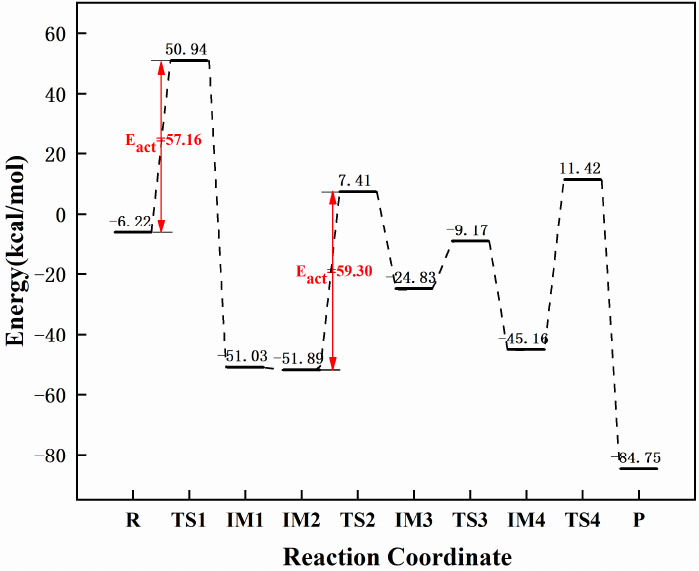
Figure 12. The most favorable energy path diagram for the hydrogenation of acetylene on graphene- NiN 2 (C).